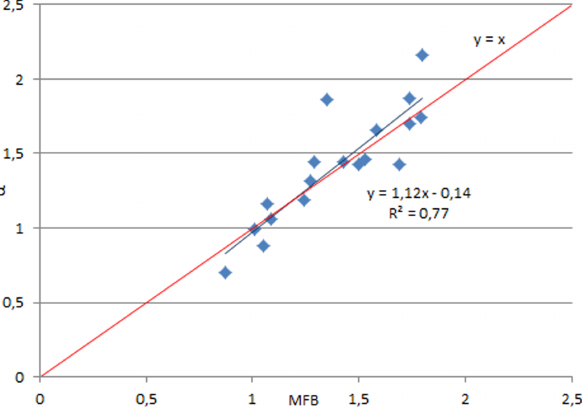
Fig. 10. Regression of α versus MFB. y = x is drawn in red and the regression in blue.